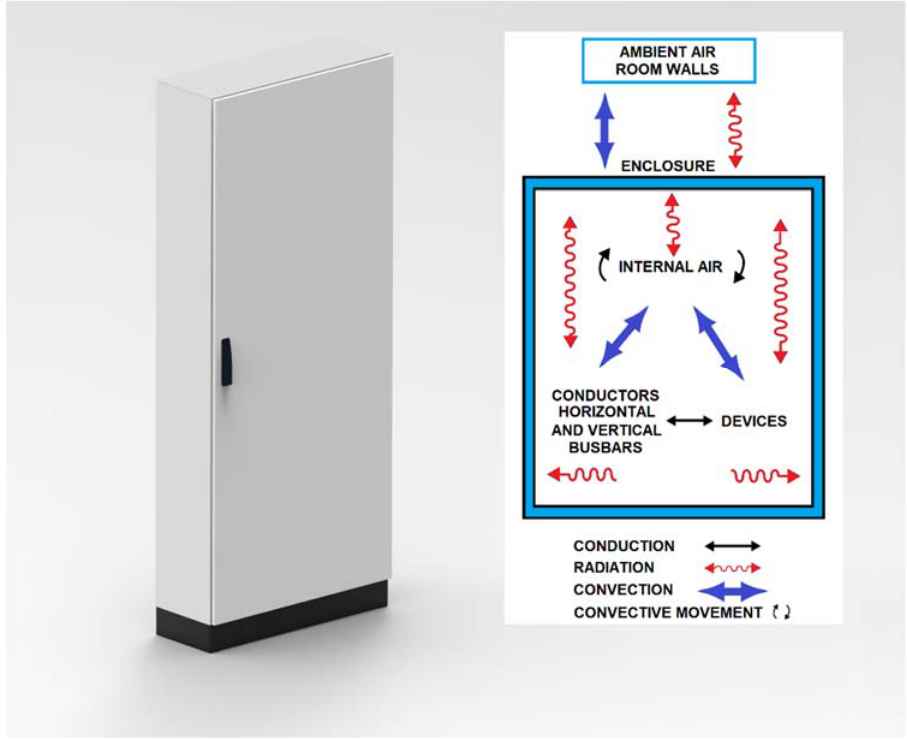
Figure 1. A scheme of heat dissipation in the switchgear by means of conduction, convection, and radiation.